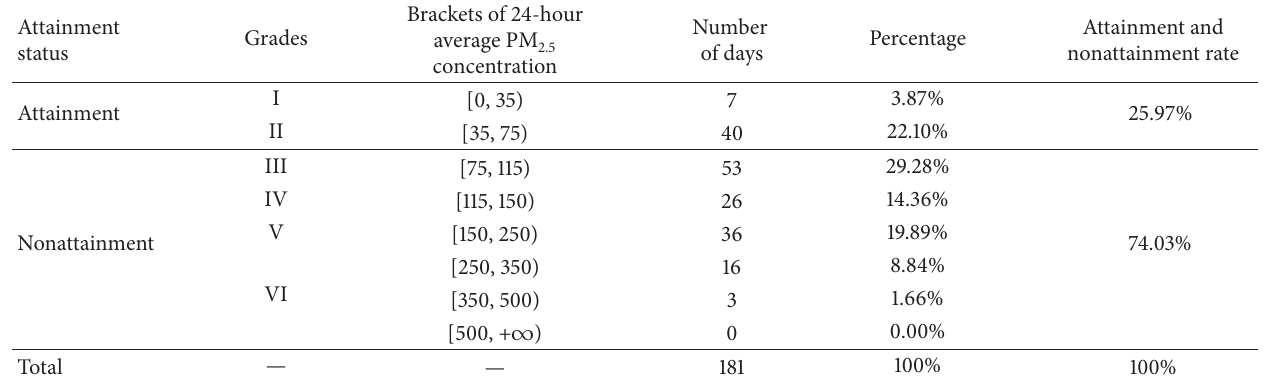
Table 3: Breakdown of the number of days in terms of primary pollutants.